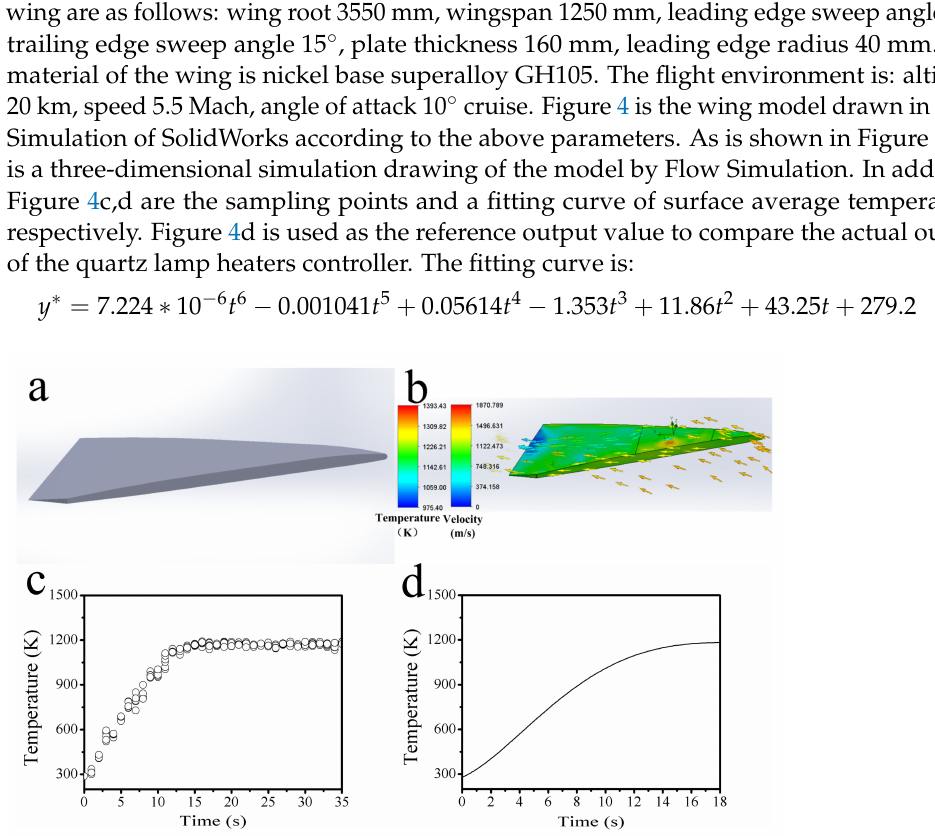
Figure 4. ( a ) Three-dimensional drawing and ( b ) flow simulation of the hypersonic vehicle’s wing; ( c ) sampling points and ( d ) a fitting curve of surface average